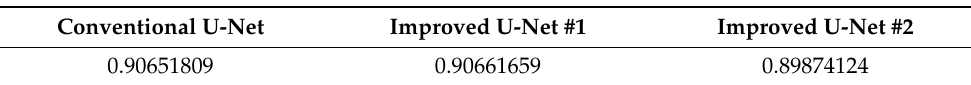
Table 11. AUC (large number of particles).